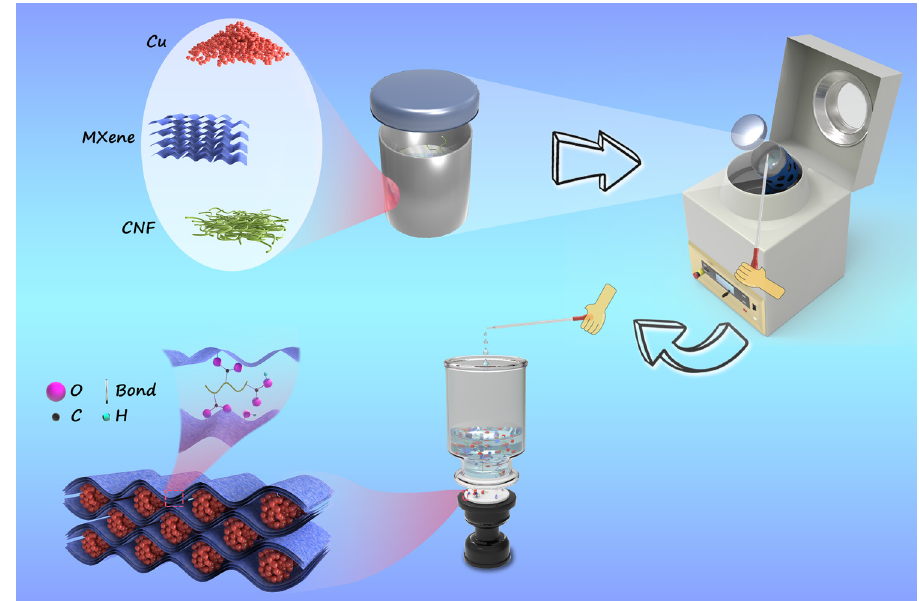
Figure 1: Schematic diagram of the preparation of the MXene/Cu/CNF fi